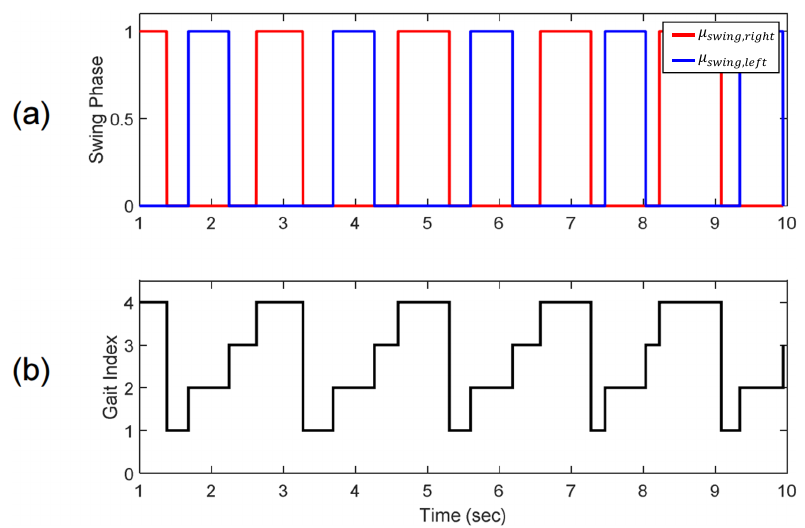
Figure 6. Gait index measurement results: ( a ) swing phases of both legs. Values of 1 represent the swing phase and values of 0 represent the stance phases. ( b ) Representative gait